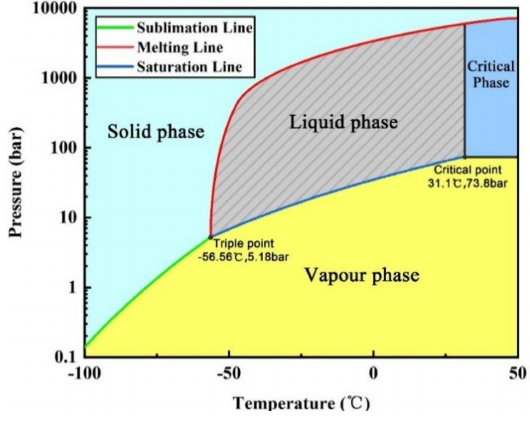
Figure 1. CO 2 phase